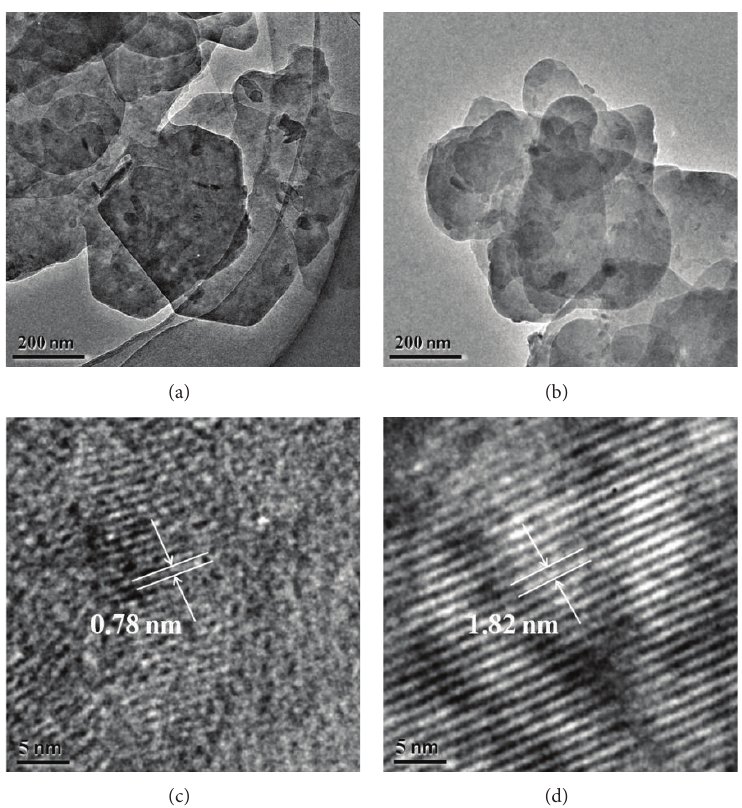
Figure 6: TEM and high resolution TEM images of the samples: ((a), (c)) Zn/Al-CO 32− -LDH and ((b), (d)) Zn/Al-HNOB −